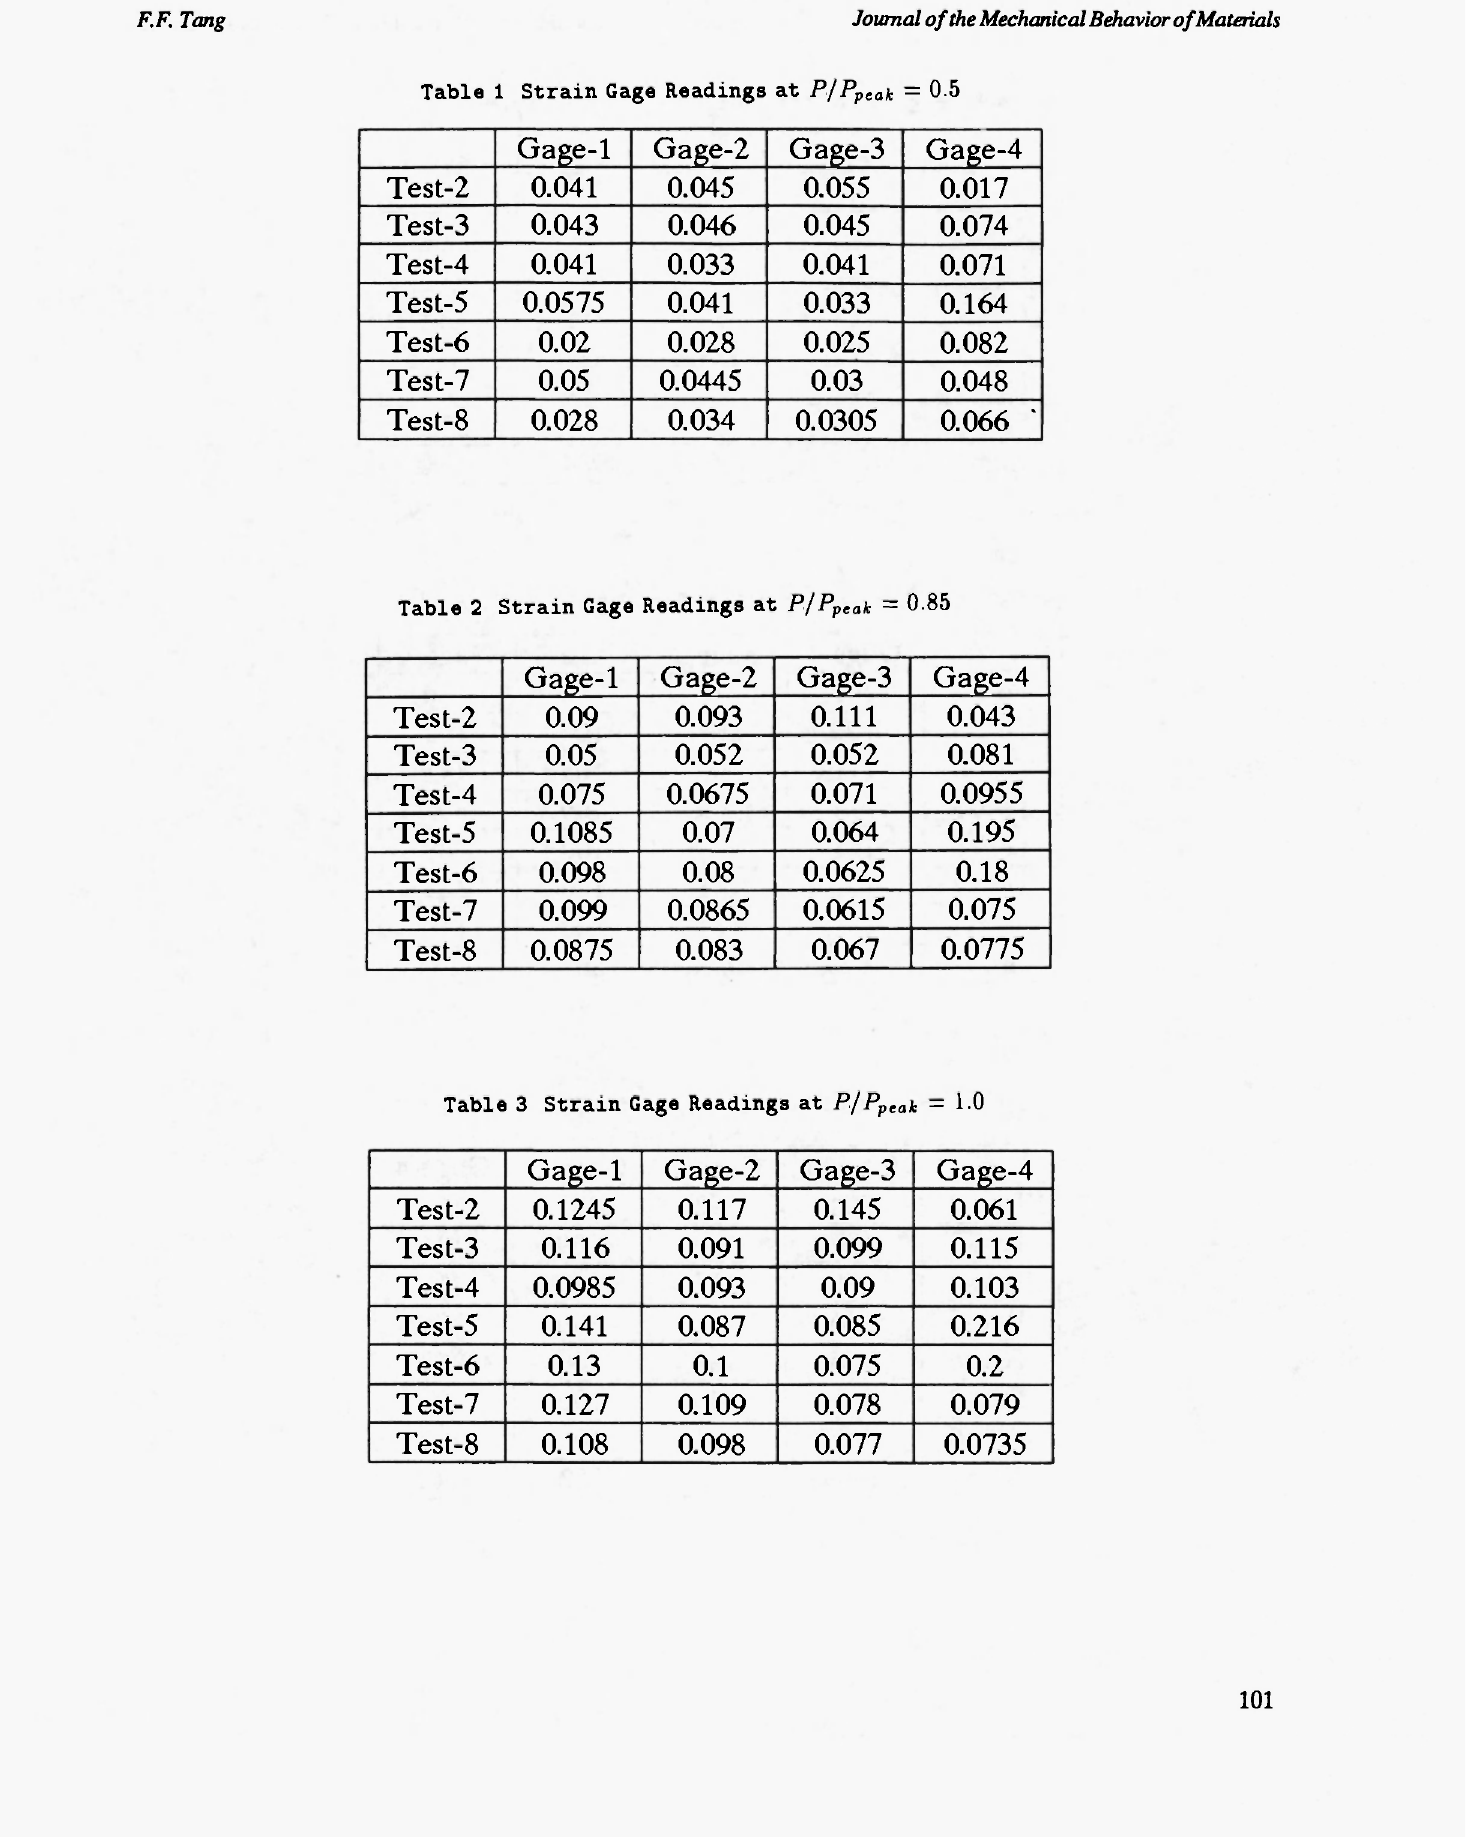
Table 1 Strain Gage Readings at P/P pea k